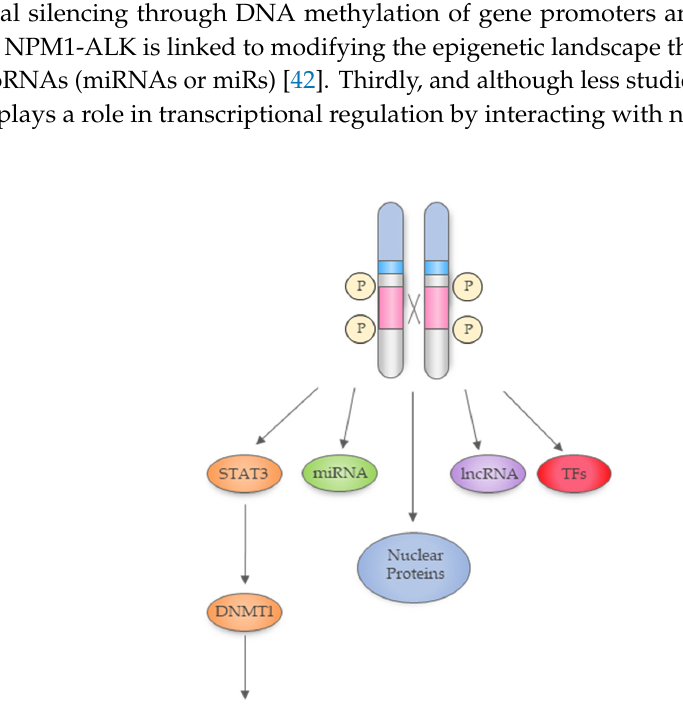
Figure 3. The NPM1-ALK fusion protein drives epigenetic change through DNA methyltransferase (DNMT), miRNA, and transcription factor (TF) expression and through interacting with nuclear proteins.